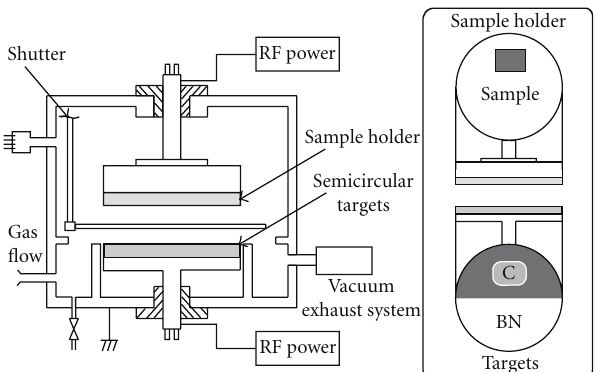
Figure 1: Schematic of RF sputtering.